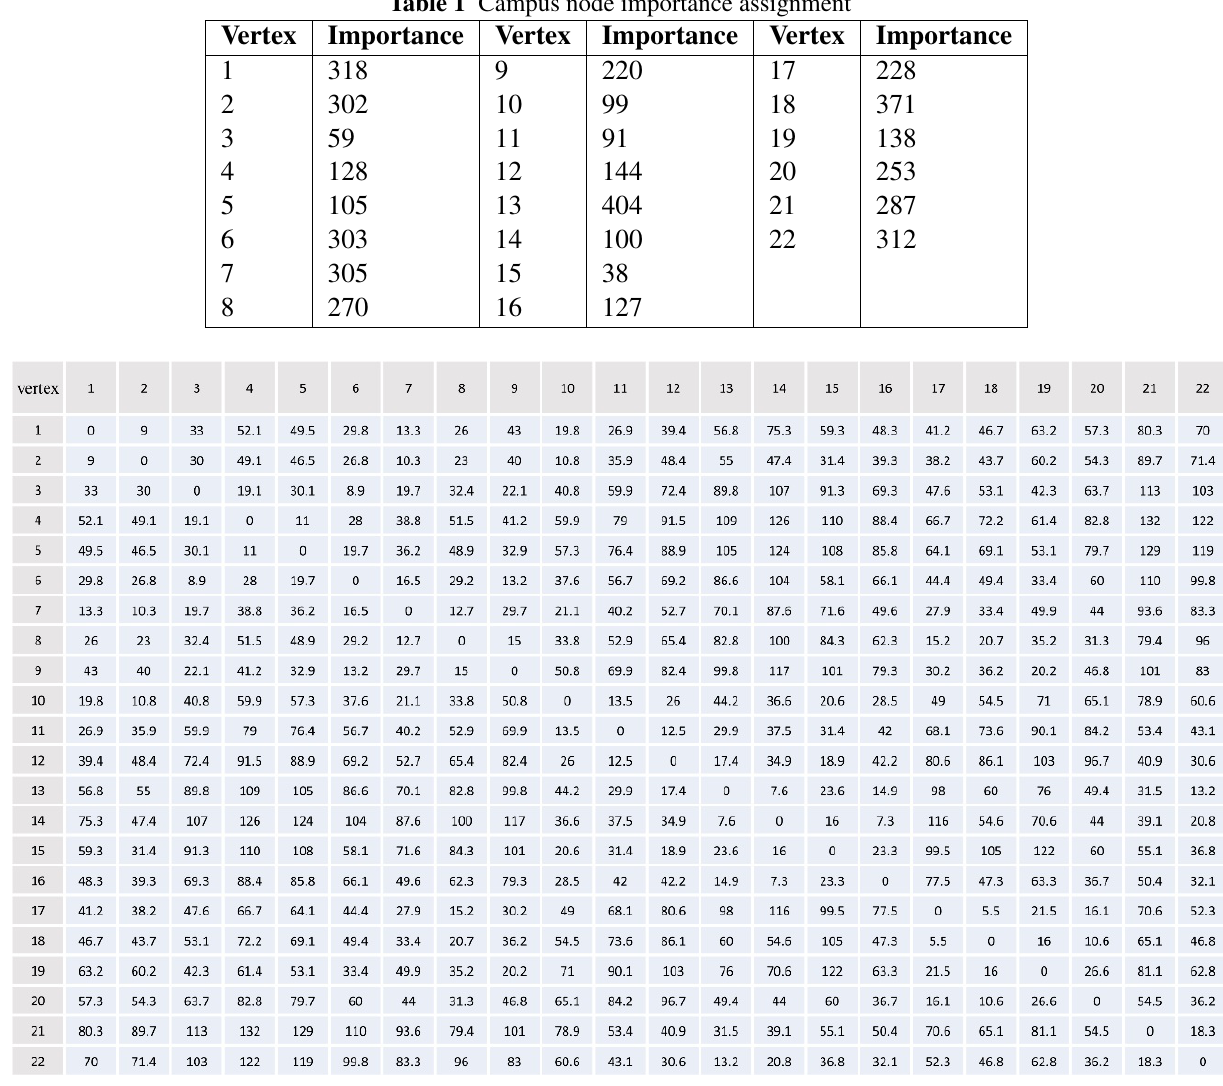
Fig. 2 Shortest path distance d from each vertex to other vertices unit (per unit